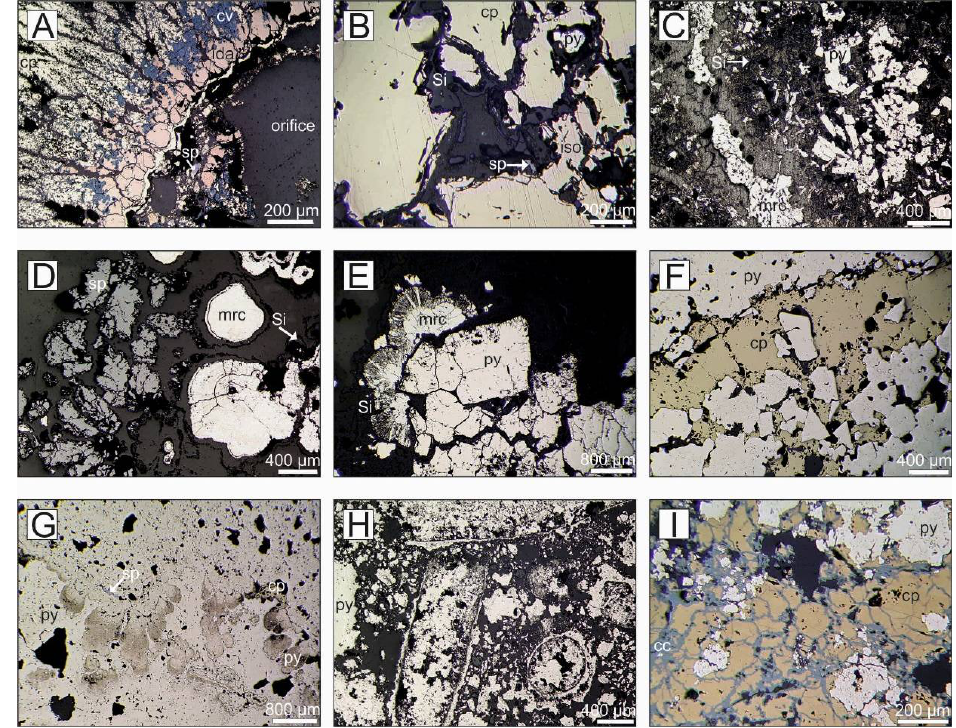
Figure 5. Reflected photomicrographs of representative mineral assemblages and textures from surface samples obtained by HyBIS during cruise JC138. ( A ) Cross-Section of chimney comprising of tetrahedral shaped coarse-grained chalcopyrite, subhedral idaite altered to covellite along grain boundaries, New M. #2, 55-1. ( B ) Coarse-grained chalcopyrite with exsolution lamella of isocubanite and coated by a thin layer of amorphous silica, New M. #3, 055-6. ( C ) Pyrite pseudomorphs after tabular pyrrhotite associated with marcasite, New M. #3, 055-6. ( D ) Radial aggregates to colloform marcasite associated with dendritic sphalerite and coated with thin layer of amorphous silica, New M. #2, 55-3. ( E ) Cubic to subhedral aggregates of pyrite overgrown by colloform marcasite and hosted in amorphous silica, Shinkai M., 55-8. ( F ) Massive recrystallized pyrite with intercalated layer of chalcopyrite, Southern M., 21-3. ( G ) Colloidal aggregates of pyrite overgrown by massive pyrite that host inclusions of sphalerite and chalcopyrite, Southern M., 41-4. ( H ) Fine-grained pyrite with fossil remnants of tube worms, Southern M., 41-6. ( I ) Pyrite clasts surrounded by chalcopyrite that is altered to chalcocite along